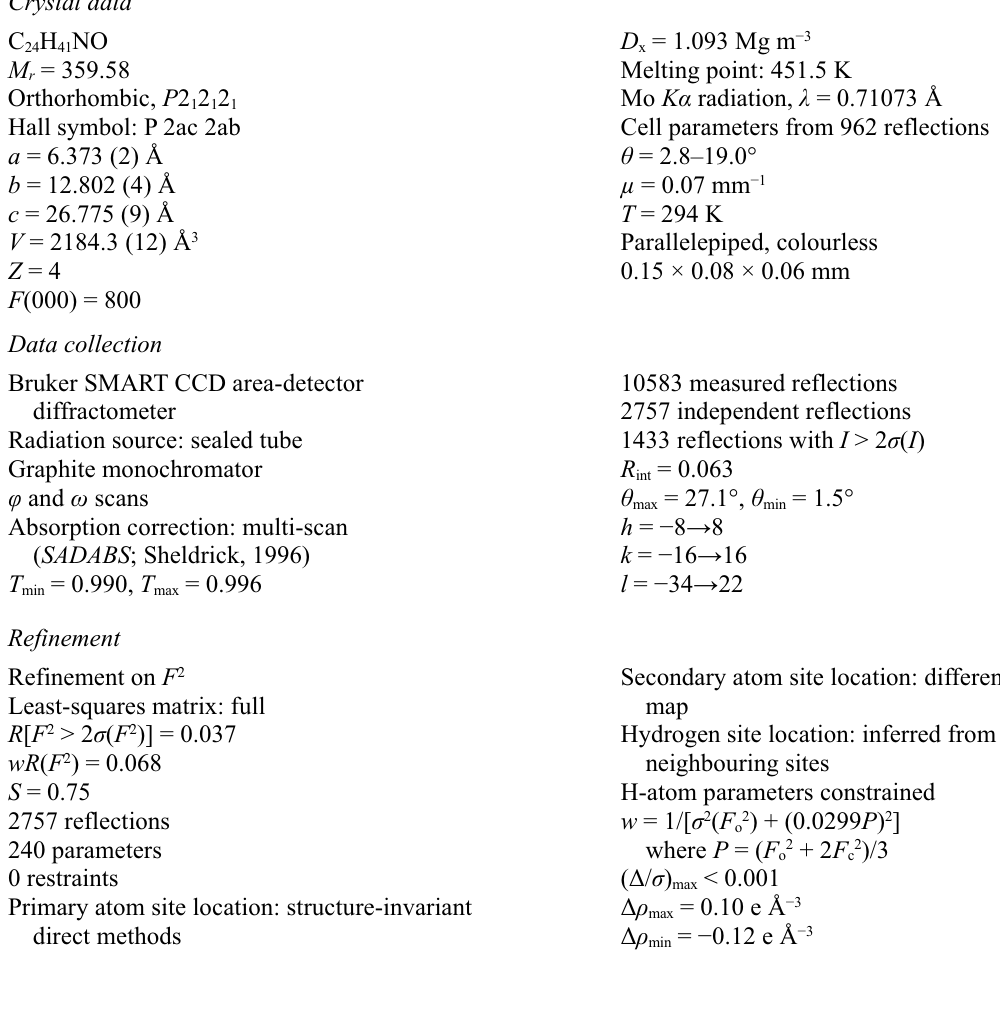
Figure 1 The molecular structure of (I), with atom labels and 30% probability displacement ellipsoids for non-H atoms. N - tert -Butyl-5 α -androstane-17 β -carboxamide Crystal